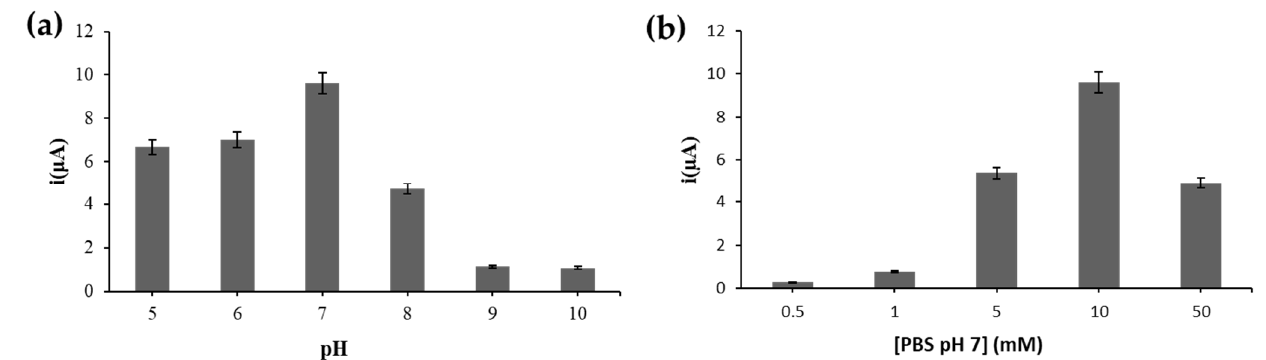
Figure 6. ( a ) Effects of pH from pH 5 to pH 10 and ( b ) PBS concentration from 0.5 mM to 50 mM containing 0.1 M KCl on the DNA biosensor response. The DPV response was recorded using a scan rate of 100 mVs − 1 .